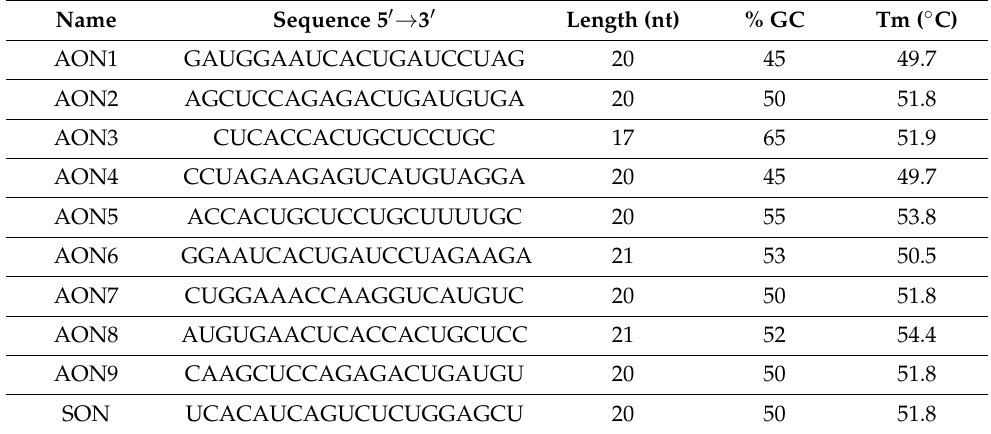
Table 1. Antisense oligonucleotide (AON) sequences and